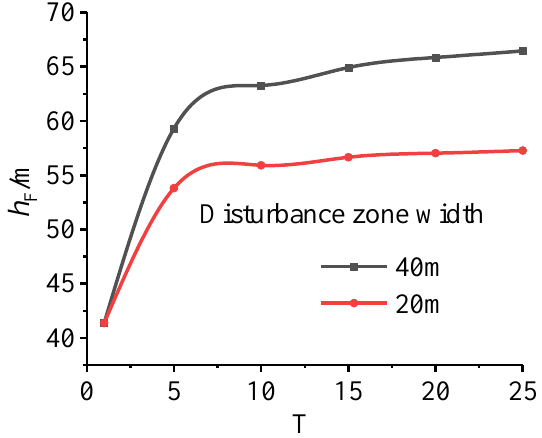
Figure 5. Head height curve of the inner edge of the supporting structure.